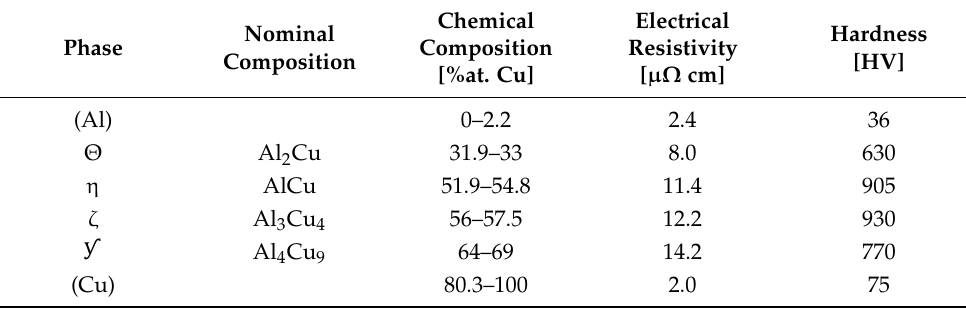
Table 5. Characteristics of intermetallic compounds [20].